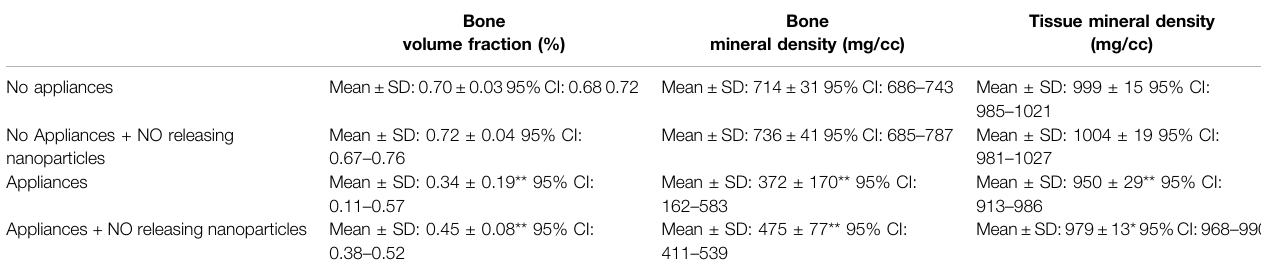
TABLE 1 | Intra-radicular alveolar bone quality measures.